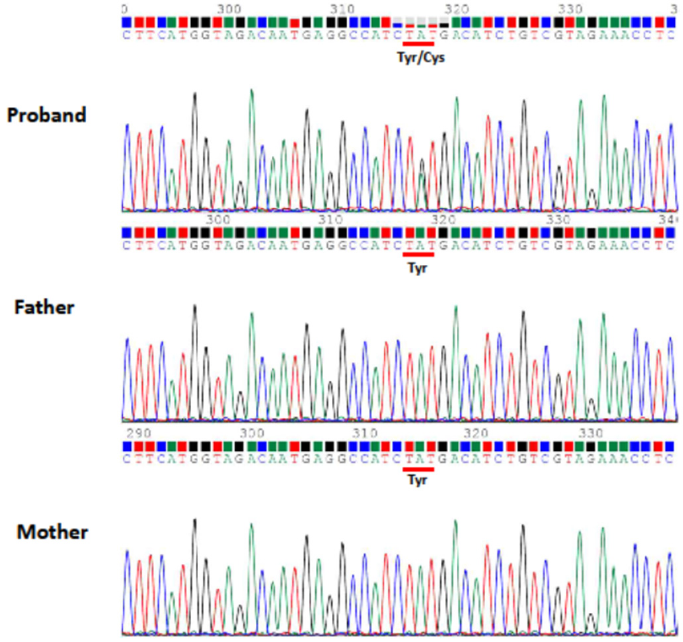
Figure 6. Sanger sequencing confirmed TUBA1A de novo mutation (NM_006009.4: c.629A>G; p.Tyr210Cys) of Case 2 identified by whole exome sequencing (WES). Table 1. Clinical presentation of Case 1 (TUBB2B mutation) and Case 2 (TUBA1A